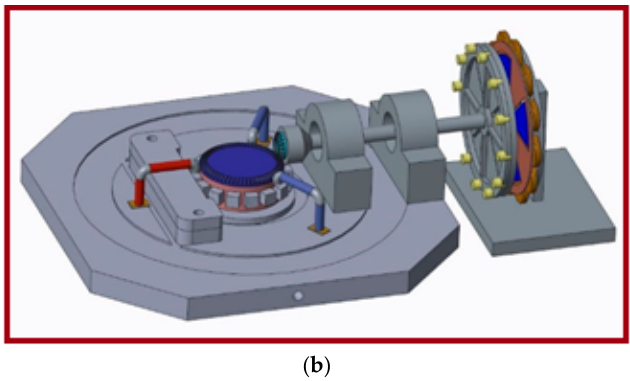
Figure 5. Schematic diagram of the integrated thermomagnetic engine with the hybrid (TENG-EMG) generator: ( a ) cross sectional view of the system; and ( b ) isometric view of the system.